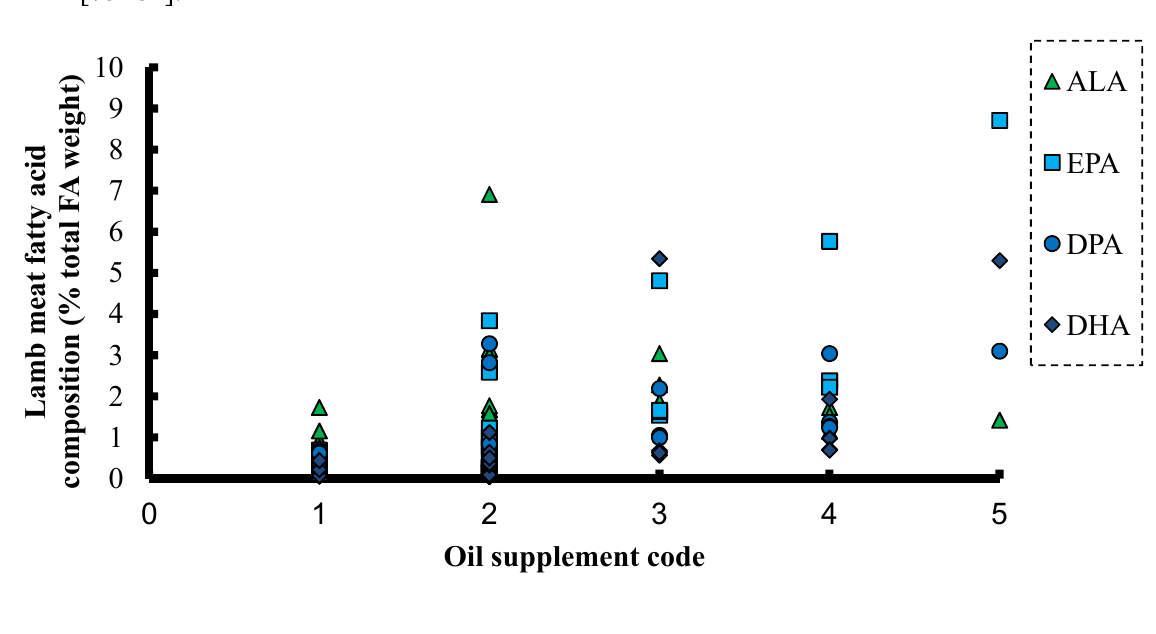
Figure 4. Levels of omega-3 PUFA (ALA) and omega-3 LC-PUFA (EPA, DPA and DHA) in trimmed lean muscle of lambs on a diet with: (1) no oil supplement; (2) linseed or linseed oil; (3) fish oil–vegetable oil mix; (4) fish oil; or (5) fish oil–marine